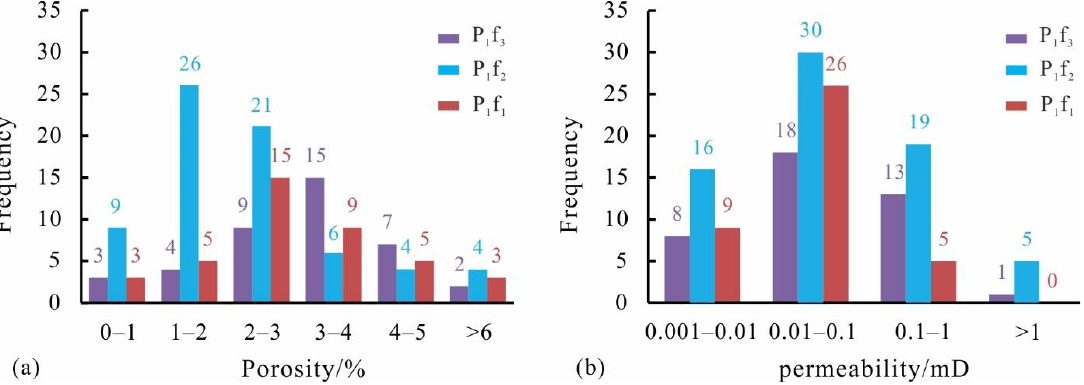
Figure 4. Frequency distribution of the physical properties of the different members in the Fengcheng Formation: ( a ) porosity; ( b ) permeability.